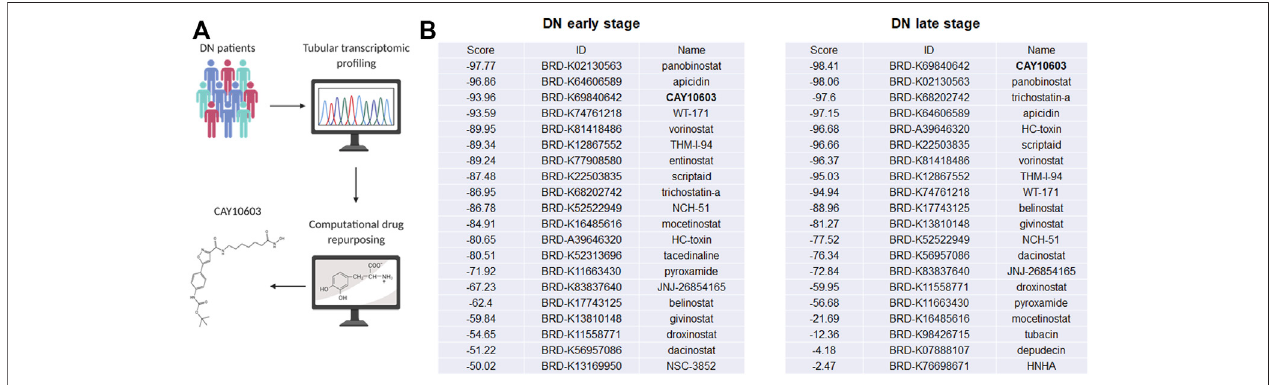
FIGURE 1 | Tubular transcriptomics from a biopsy-proven DN patient-based drug repurposing approach to identify potential drugs for treatment. (A) Schematic view of work fl ow. (B) The top 20 HDAC inhibitors are sorted in each stage, and CAY10603 is highlighted in